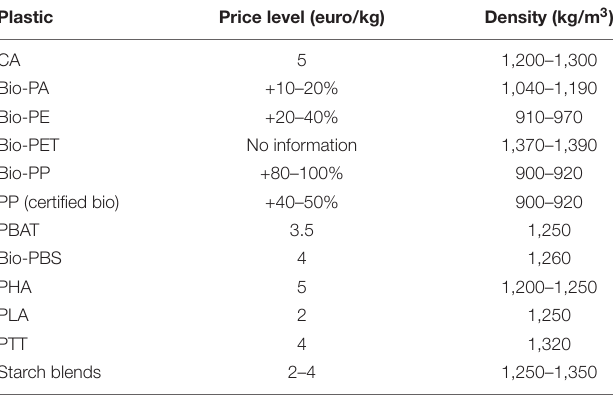
TABLE 2 | Price level for bio-based and/or biodegradable plastics.